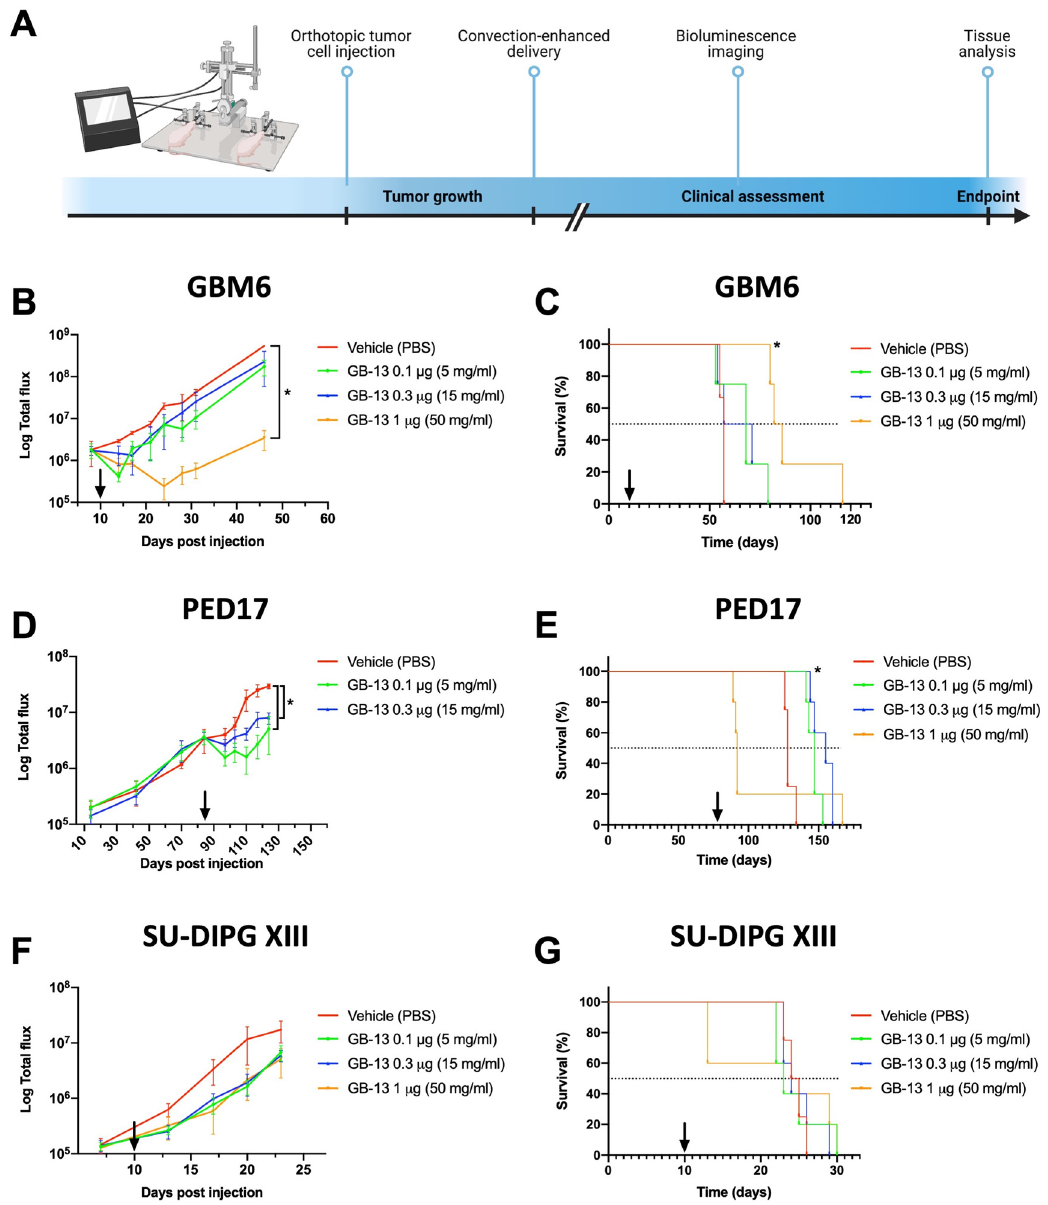
Figure 3. CED infusion of GB-13 results in reduced BLI signals and prolonged survival of IL-13R α 2-upregulated DMG and adult GBM patient-derived xenografts grown as orthotopic tumors. ( A ) Schematic representation of tumor cell injection and CED workflow (created with BioRender.com, accessed on 7 November 2021). Four to five mice were used per treatment group in each cell model (GBM6 is adult GBM with medium IL-13R α 2 levels; PED17 and SU-DIPG XIII-P are DMG with IL-13R α 2-high and IL-13R α 2-low levels, respectively). A single 1 μ g dose of GB-13 by CED (arrow) results in decreased ( B ) BLI signals ( p = 0.01) and ( C ) prolonged survival of GBM6-bearing animals ( p = 0.01). ( D ) BLI signals in PED17 xenografts are reduced following 0.1 μ g ( p = 0.0001) or 0.3 μ g ( p = 0.0004) of GB-13. ( E ) 0.1 μ g ( p = 0.003) and 0.3 μ g ( p = 0.003) dose levels extend survival without a notable dose–response, but a 1 μ g dose of GB-13 is associated with lethal toxicity in 4 out of 5 animals approximately 72 h after the infusion. In SU-DIPG XIII-P animals, CED of GB-13 is not associated with ( F ) reduced BLI signals or ( G ) survival benefit. BLI data are presented as the mean ± standard deviation, and significance between groups was calculated using two-tailed Student’s t - tests. Significance of endpoint comparison between treatment groups were calculated using the Log-Rank test.